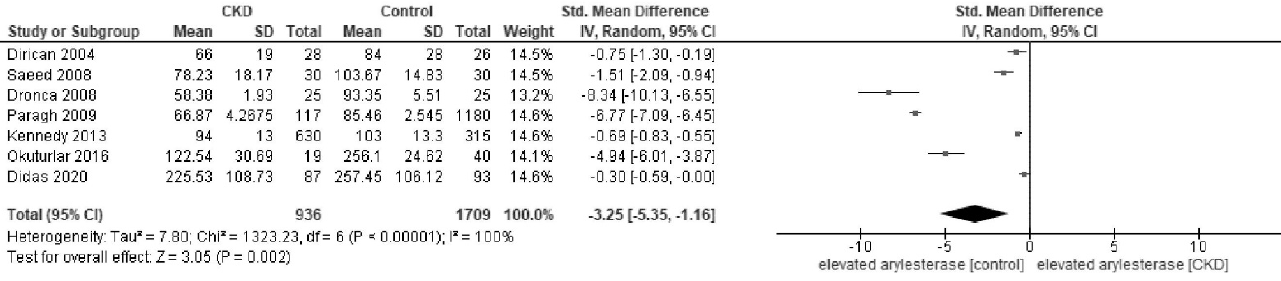
Figure A7. Forest plot of arylesterase activity in the sensitivity analysis [28,30,32,34,39,41–43,45–47].